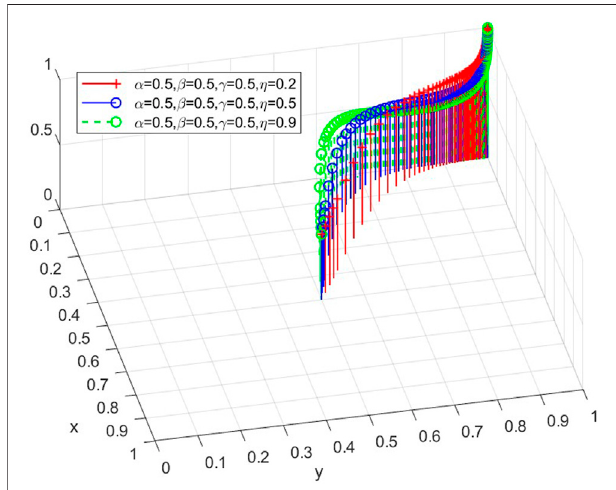
FIGURE 5 | System evolution trajectory under different propaganda and guidance efforts η